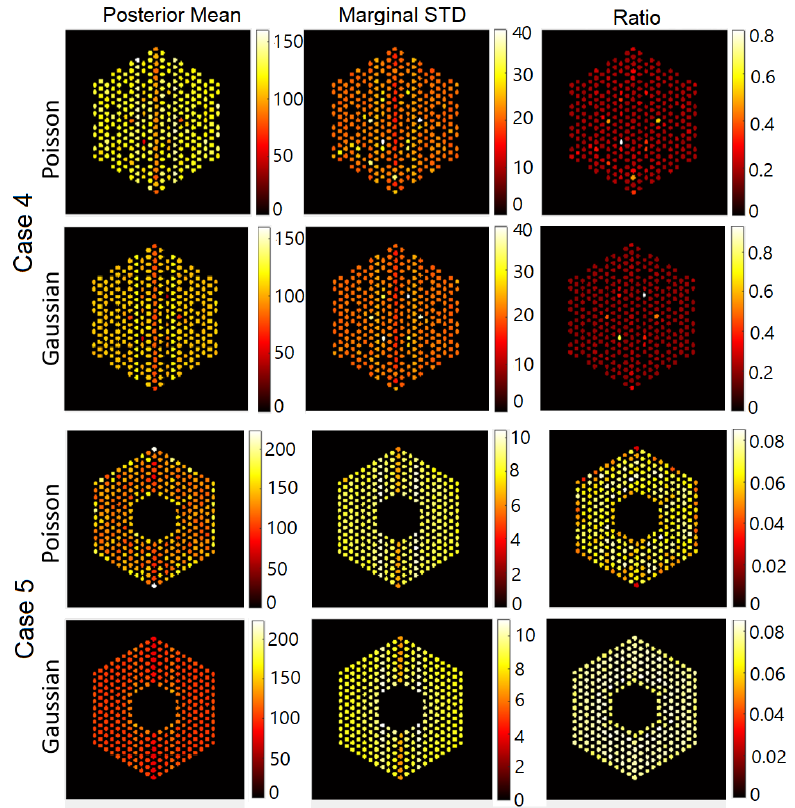
Figure 21. The EMPIRICAL response matrix: pin pixels averaging of the proposed approach for Case “4” and Case “5” using the “EMPIRICAL” response matrix. ( Left-hand column ): posterior mean; ( middle column ): marginal standard deviation; and ( right-hand column ): the ratio of marginal standard deviation divided by posterior